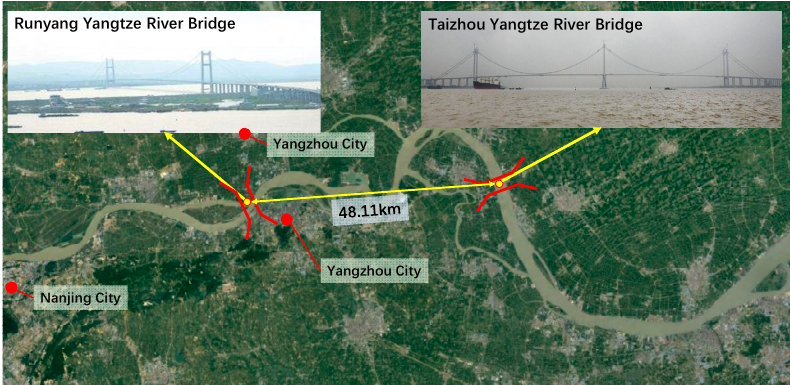
Figure 9. Location of Runyang Bridge and Taizhou Yangtze River Bridge.